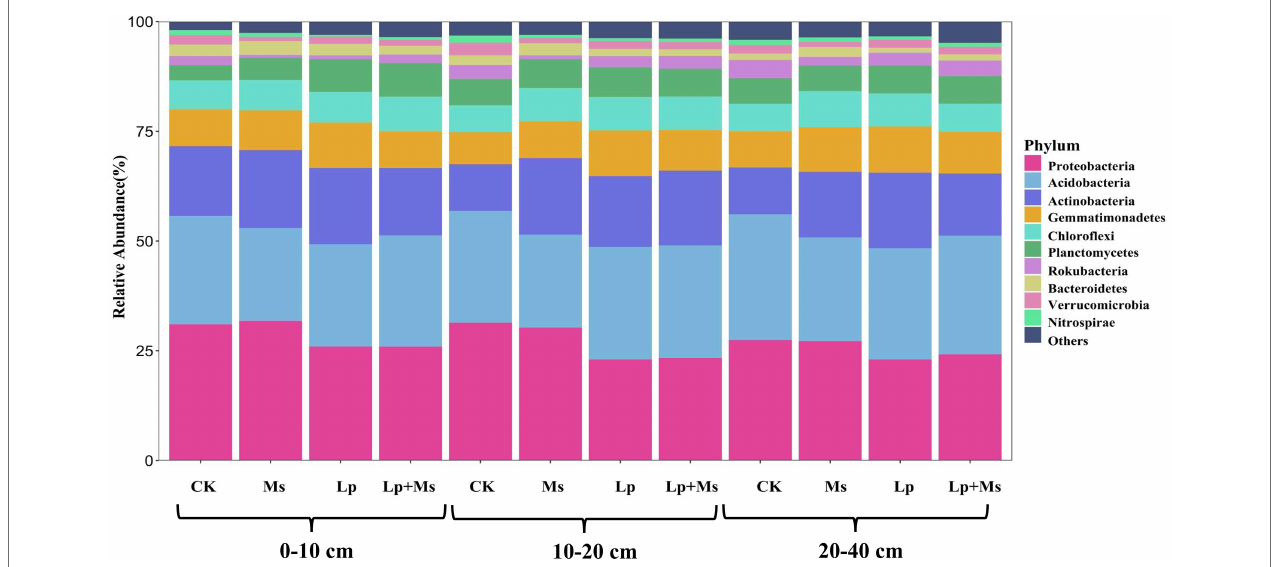
FIGURE 5 | Composition of soil bacterial communities under different grass patterns at phylum and genus